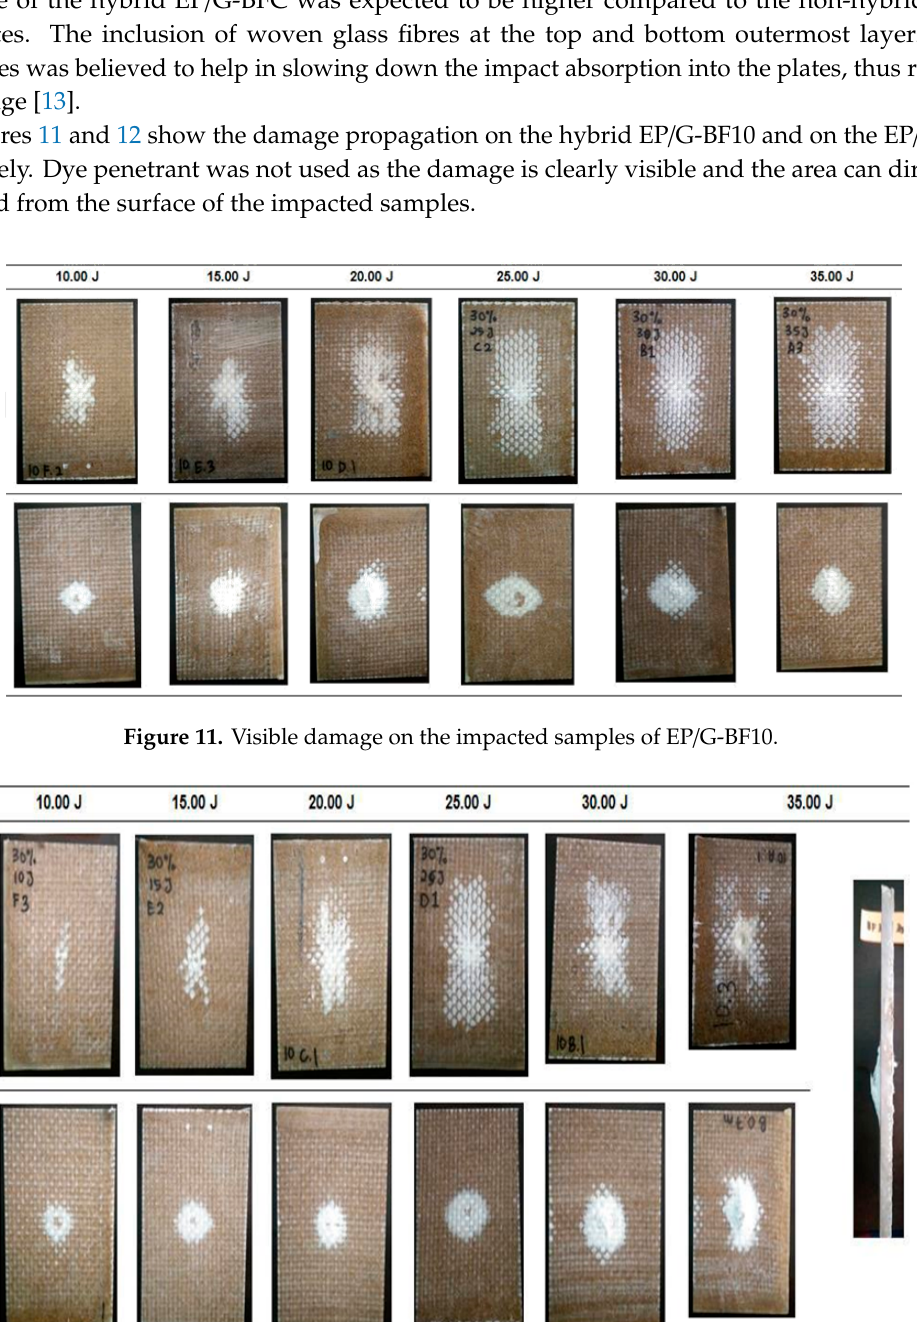
Figure 12. Visible damage on the impacted samples of the EP/G-BF30.